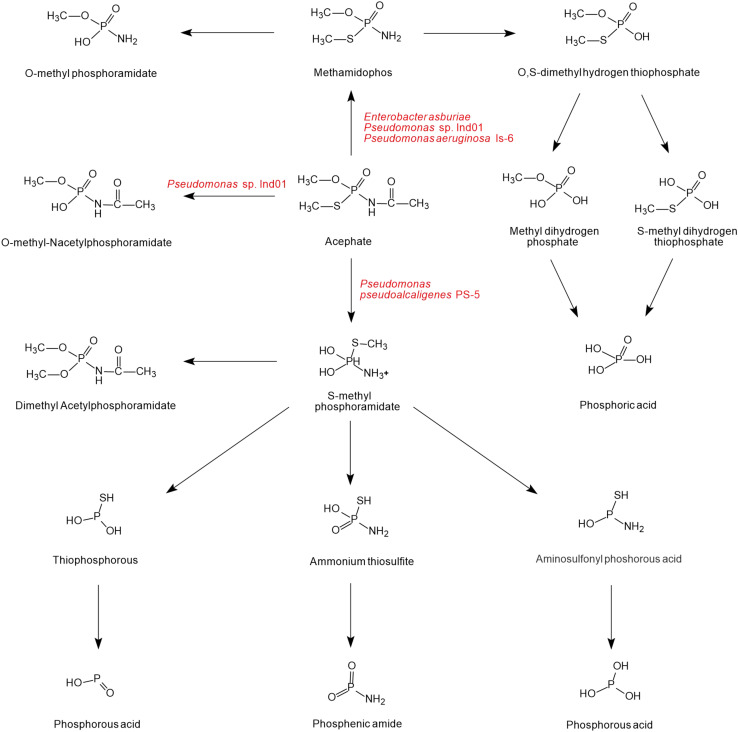
The microbial degradation pathways of acephate (based on Phugare et al., 2012; Pinjari et al., 2012; Ramu and Seetharaman, 2014; Singh et al., 2017).